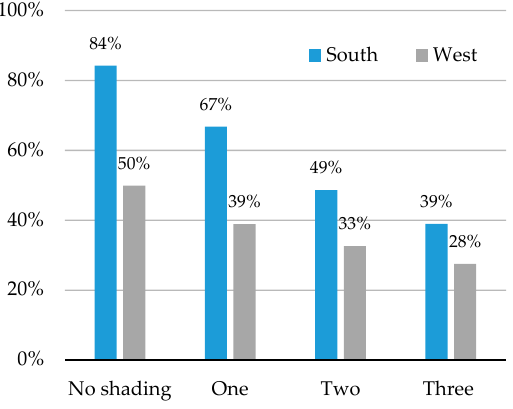
Figure 5. Shading coefficient with vertical fins.